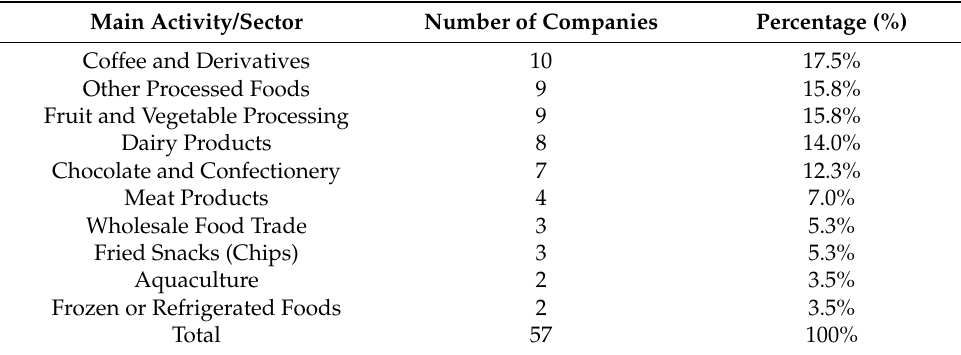
Table 4. Classification of companies according to their economic